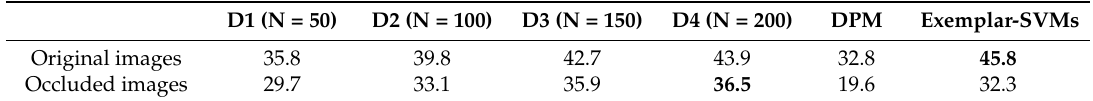
Table 4. Experiments on Caltech 101 database (aircraft sub-category) (%).